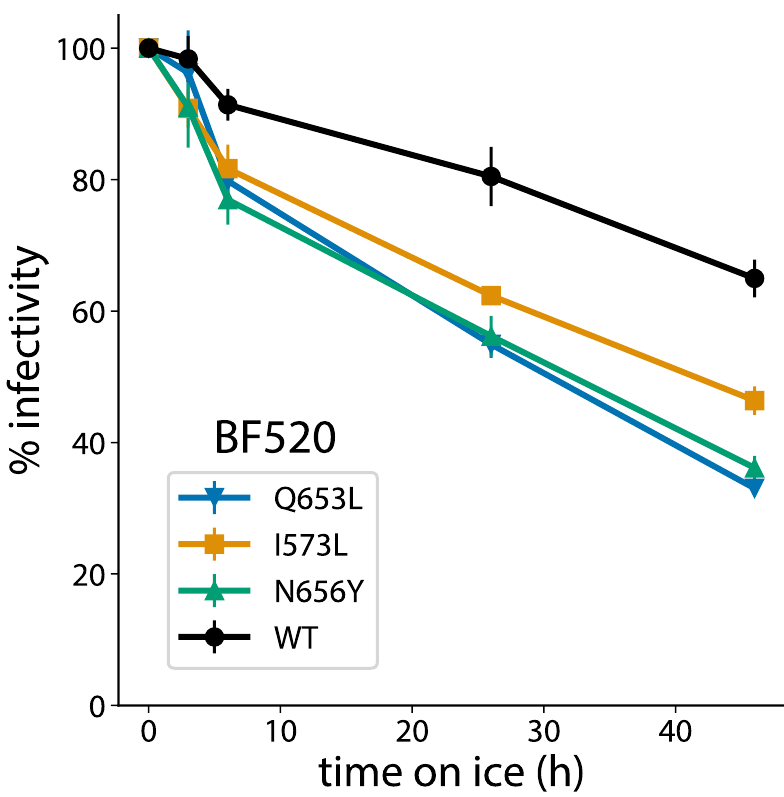
Figure 6. Cold inactivation of BF520 mutant viruses. Viruses were incubated on ice for the indicated period of time then used to infect TZM-bl reporter cells. Percent infectivity of wild-type and mutant strains are shown as a function of time incubated on ice. Each data point indicates the average of four independent replicates and error bars report the standard deviation. Infectivity of viruses not incubated on ice was set to